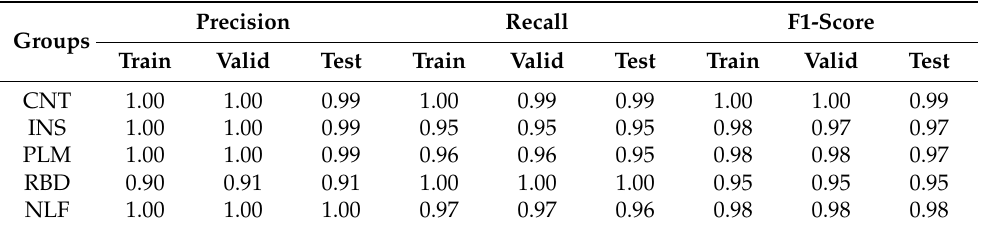
Table 4. Performance of the proposed SDN model for the automatic classification of sleep disorders based on a single-lead ECG signal.